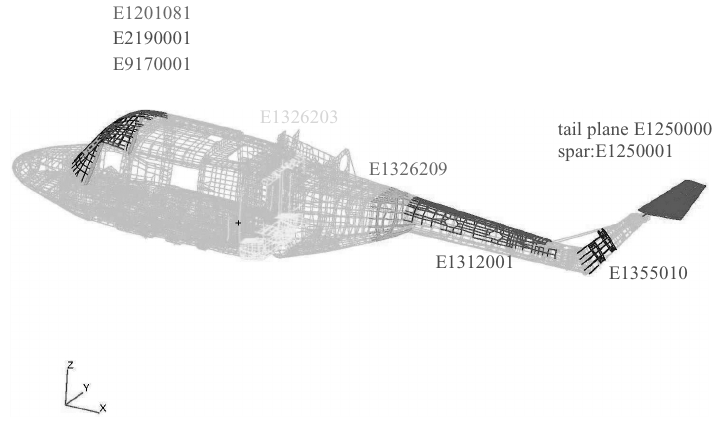
Fig. 10. Selected updating